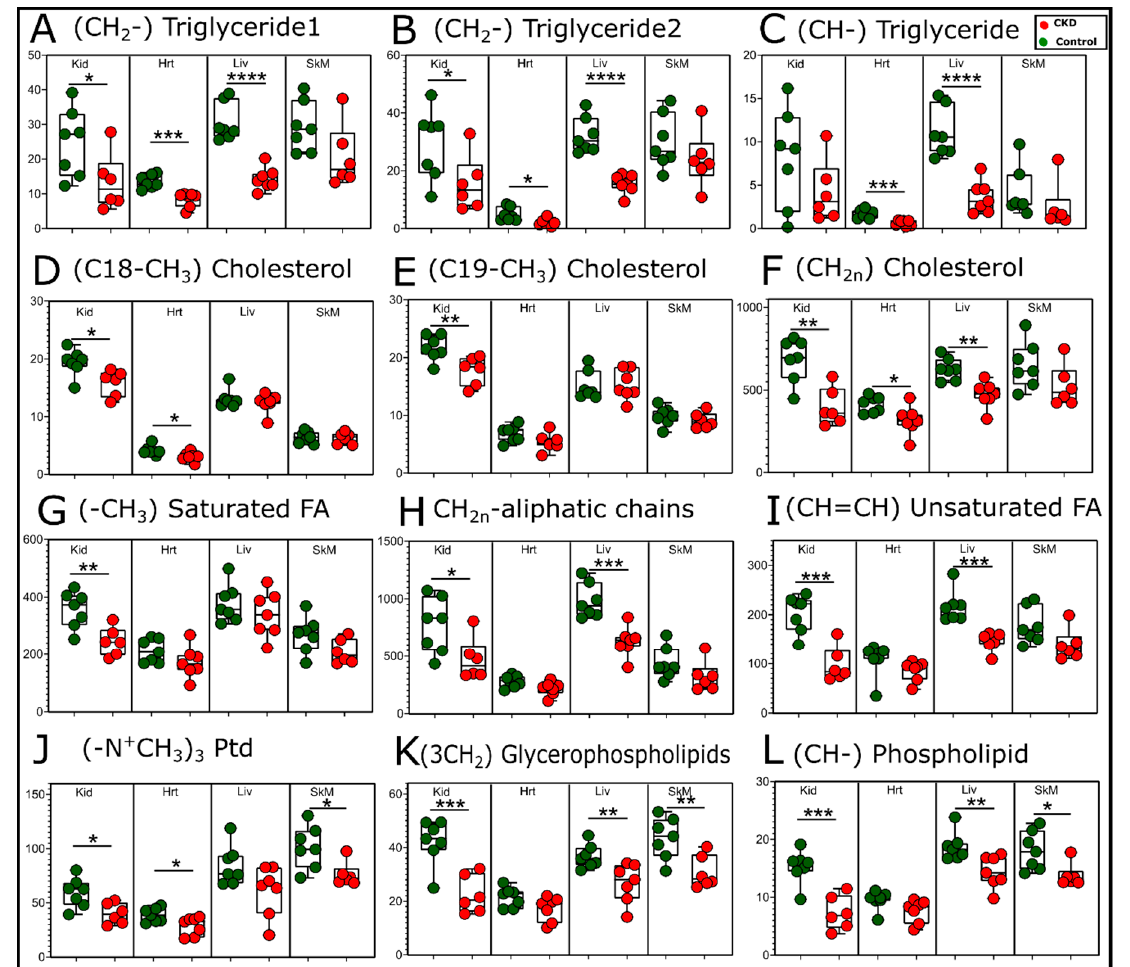
Figure 8. Changes in the lipid compounds with CKD. Quantification of the relative peak areas of selected lipid compounds obtained from organic phase samples presented as Box and Whisker plots (showing 95% confidence intervals). A two-tailed unpaired Student’s t -test was performed to determine the statistical significance, with * p < 0.05, ** p < 0.01, *** p < 0.001, and **** p < 0.0001 ( n = 7/group/tissue). Abbreviations: Kid = kidney, Hrt = heart, Liv = liver, and SkM = skeletal muscle.